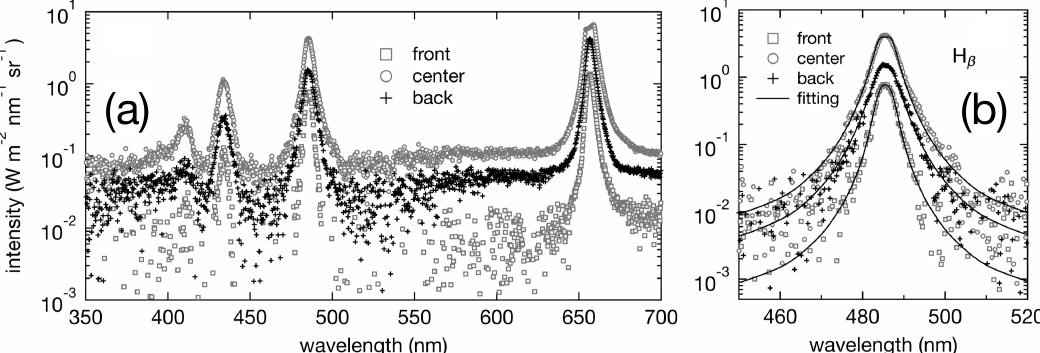
Figure 5. Spectroscopic data of the ablation cloud: ( a ) Full spectra obtained at the three timings indicated in Figure 4 ( b ) Stark-broadening least squares fitting results (solid lines) for the H β